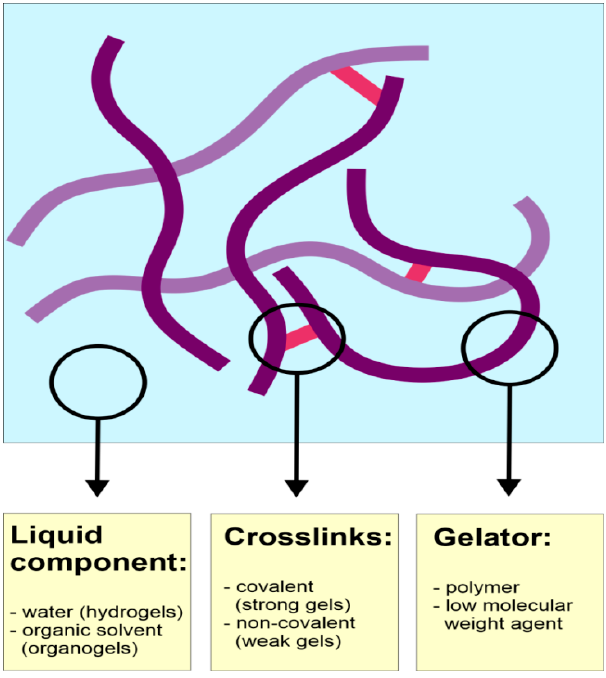
Figure 3. Classification of gels according to different criteria.